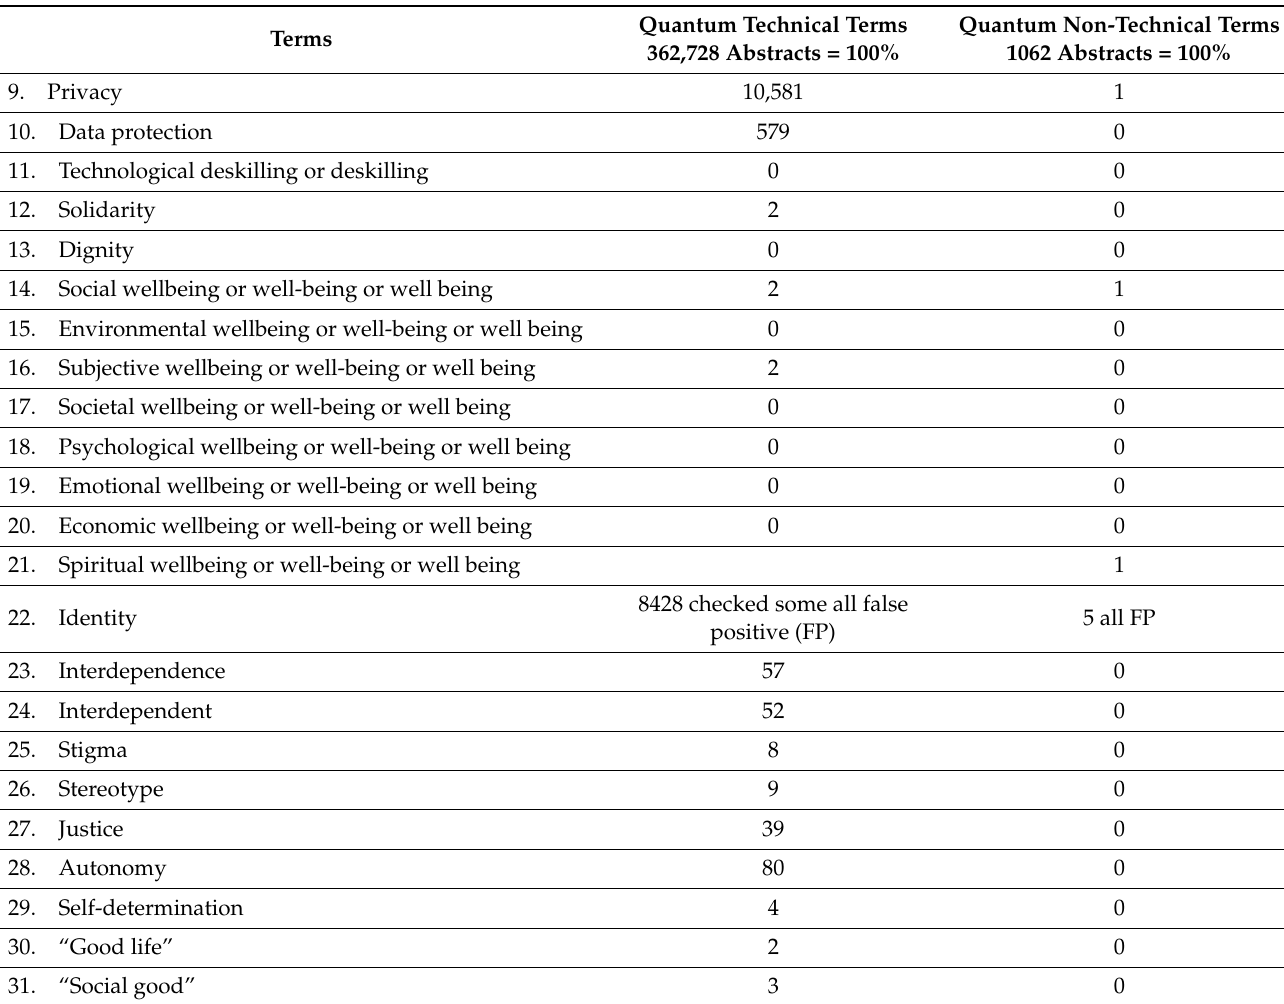
Table 3. Hit counts for other social indicators from existing literature [8,157–195] in conjunction with quantum terms